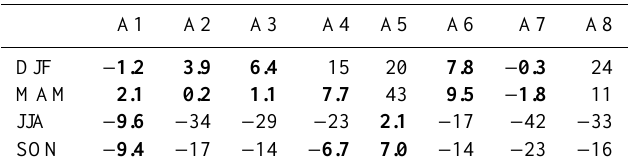
Table 1. Seasonal-mean minimal di ff erences of precipitation [%] over land between coastDat2-CCLM and the ensemble of the three obser- vational data (E-OBS, CRU, GPCC) for 1950–2010 and the eight European sub-regions of Fig. 1: British Islands (A1), Iberian Peninsula (A2), France (A3), mid-Europe (A4), Scandinavia (A5), Alps (A6), Mediterranean (A7), eastern Europe (A8). Values less than 10% are